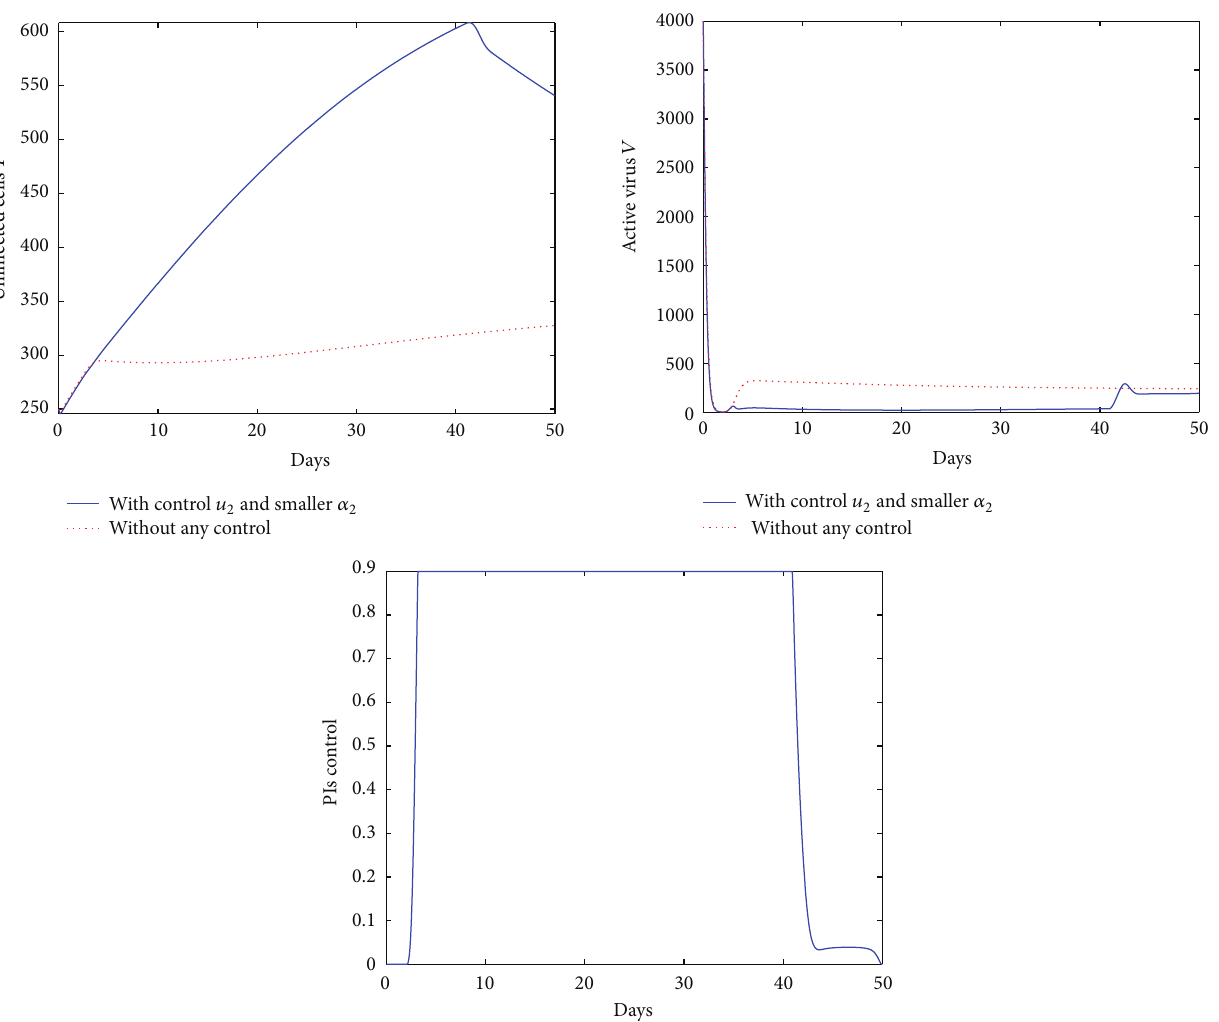
Figure 1: Optimal solutions only using PIs with sufficiently small weight coefficient 𝛼 2 for a 50-day